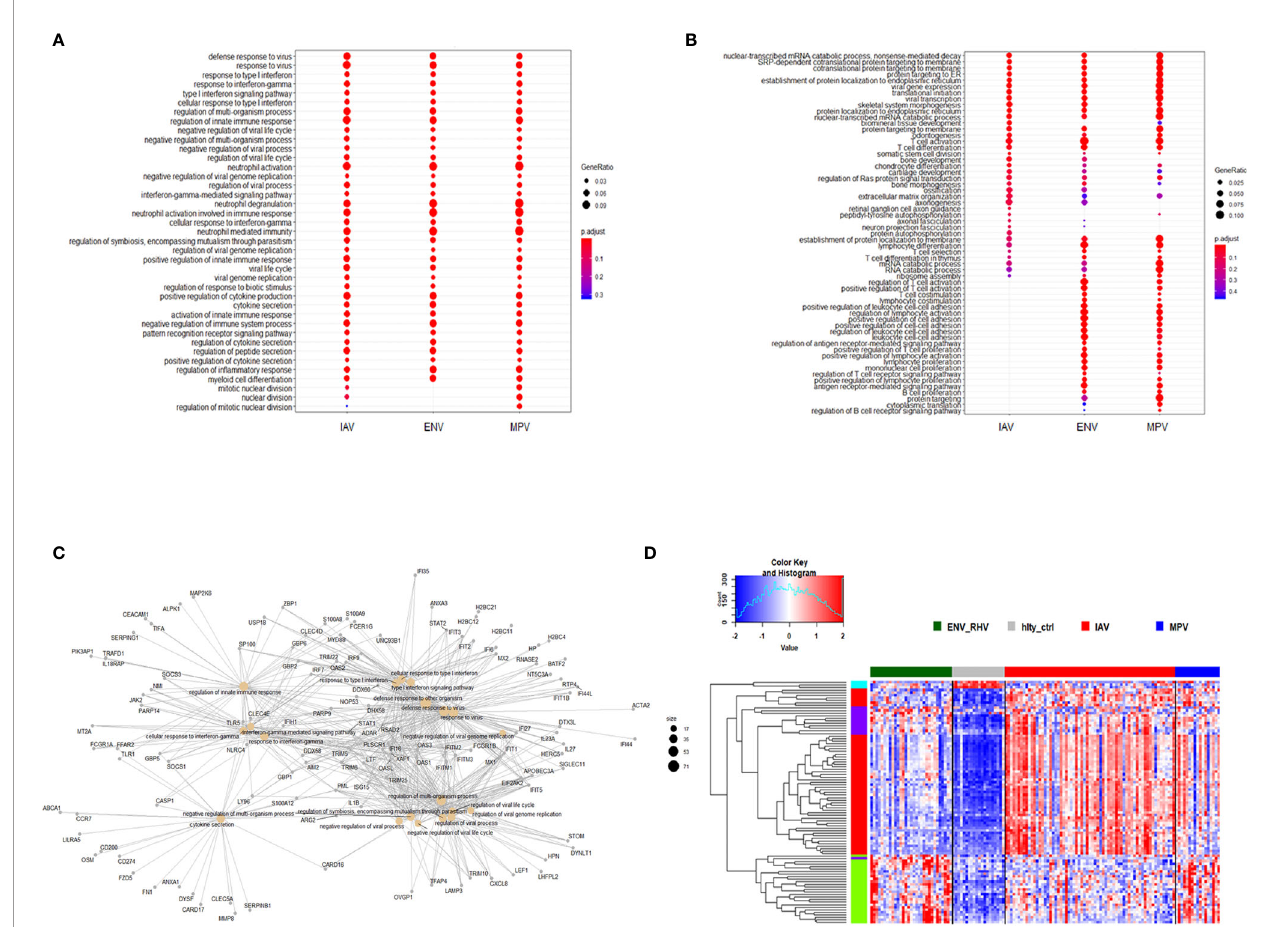
FIGURE 2 | Functional analysis of DEGs. (A) Functional analysis using GO term enrichment for the combined set of all up-regulated DEGs from the comparison of IAV, ENV and MPV versus healthy controls. The top 30 (by p-value) pathways are presented. IAV, in fl uenza virus; ENV, enterovirus/rhinovirus; MPV, metapneumovirus. (B) Functional analysis using GO term enrichment for the combined set of all down-regulated DEGs from the comparison of IAV, ENV and MPV versus healthy controls. The top 30 (by p-value) pathways are presented. (C) Functional analysis using GO term enrichment for the overlapping 598 DEGs (central part of ) of all three respiratory infections versus healthy controls. Note that all genes are grey since the fold-change cannot be displayed for the overlapping genes for three comparisons combined. (D) Expression levels of the top 150 DEGs from the comparisons of the three respiratory infection groups versus healthy controls (top 50 by log-fold change from each comparison) are presented. Values were scaled by row. red: up-regulated DEGs, blue: down-regulated DEGS. Note, that the combined 150 genes contained duplicates and the fi gure represents a total of 95 unique genes. IAV, in fl uenza virus; ENV_RHV, enterovirus/rhinovirus; MPV, metapneumovirus; hlty_ctrl, healthy